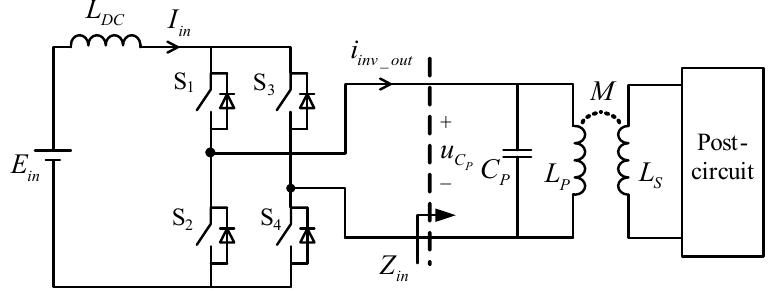
Figure 1. Current-Fed WPT system.